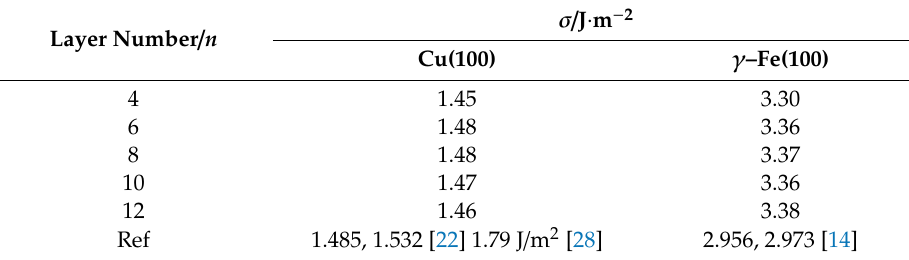
Table 3. Surface energies of Cu(100) and γ –Fe(100).